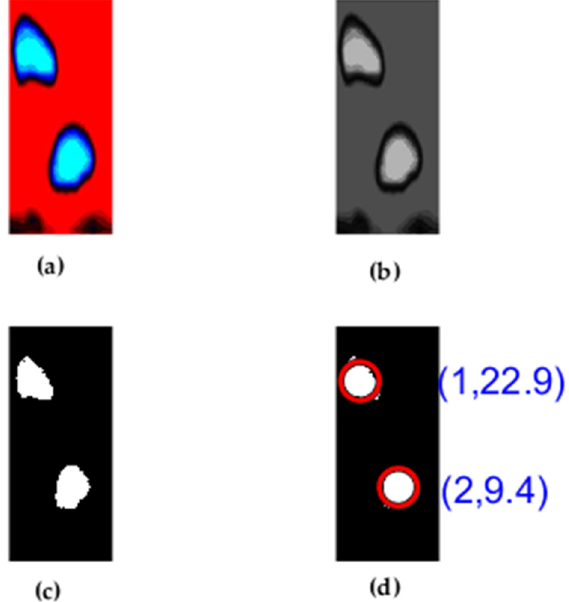
Figure 4. ( a ) RGB image extracted after post-processing; ( b ) grayscale image converted from RGB image; ( c ) binary image converted from grayscale image; ( d ) bubbles (with ID: diameter and position) distinguished from the emulsion phase (The red circle represents equivalent bubble area).